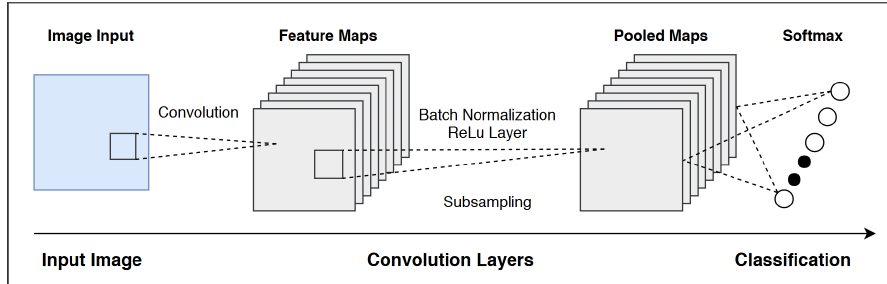
Figure 3. General architecture of a convolutional neural